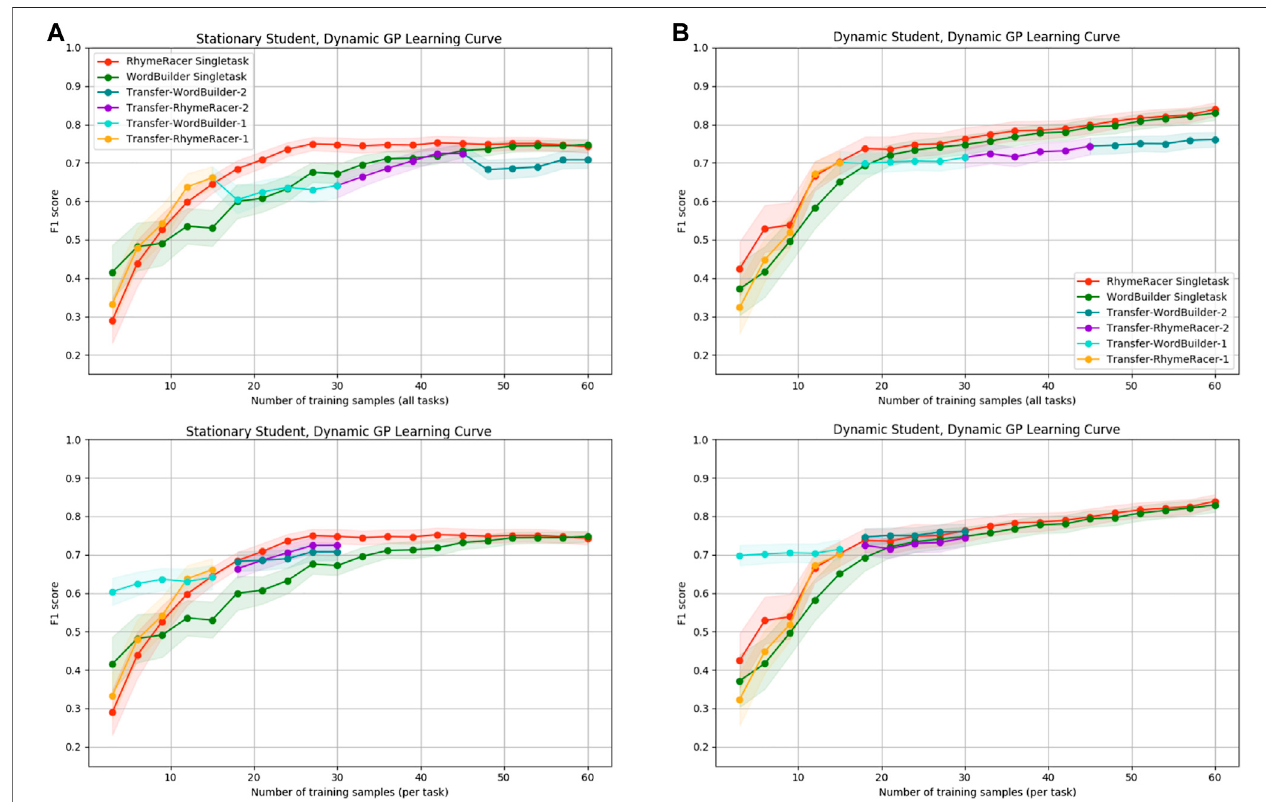
FIGURE 9 | Static-model-dynamic-student performance results (A) vs. dynamic-model-dynamic-student performance results (B) . Adding CATDaM to GP models improves modeling performance in nonstationary environments, while preserving ef fi ciency bene fi ts of multitask personalization.